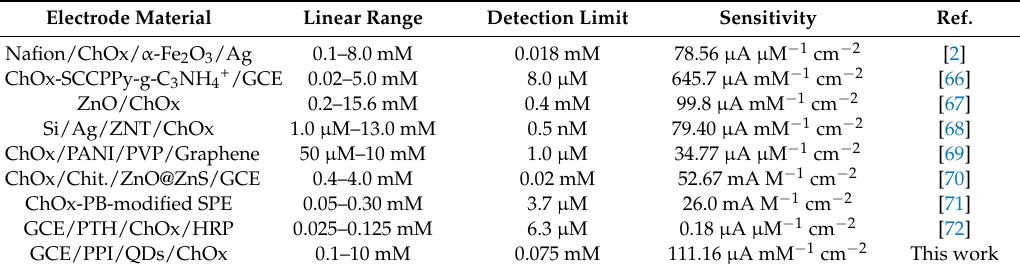
Figure 6. Square wave voltammetry (SWV) of GCE/PPI/QDs/ChOx biosensor upon successive addition of cholesterol (0.1–10 mM) in 10 mM PBS (pH 7.2) ( A ). Calibration plot of cholesterol at different concentrations ( B ). Table 2. Comparison of analytical performance of some cholesterol biosensors constructed based on different modified electrode